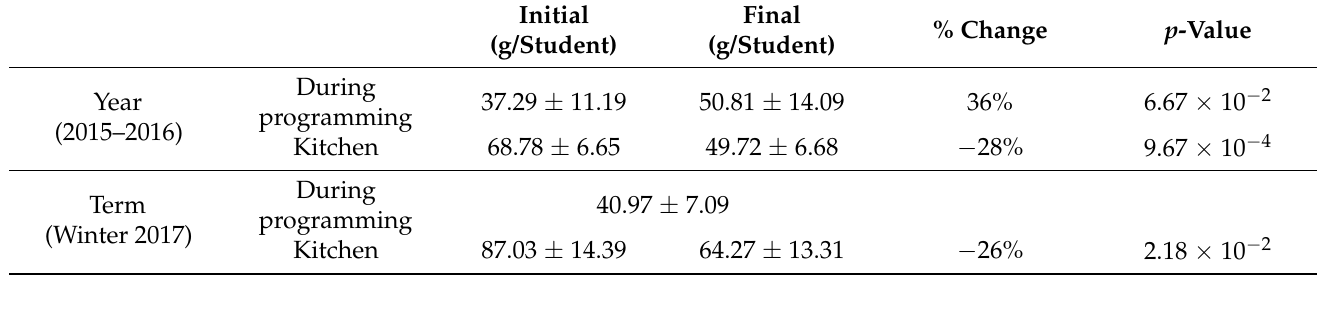
Table 2. Comparison of average food waste per student over an academic year of programming and within a single term. Data collection and comparison occurred within the week of programming and in the kitchen (out of sight of the students) the week before and/or after programming in order to control for social desirability bias.